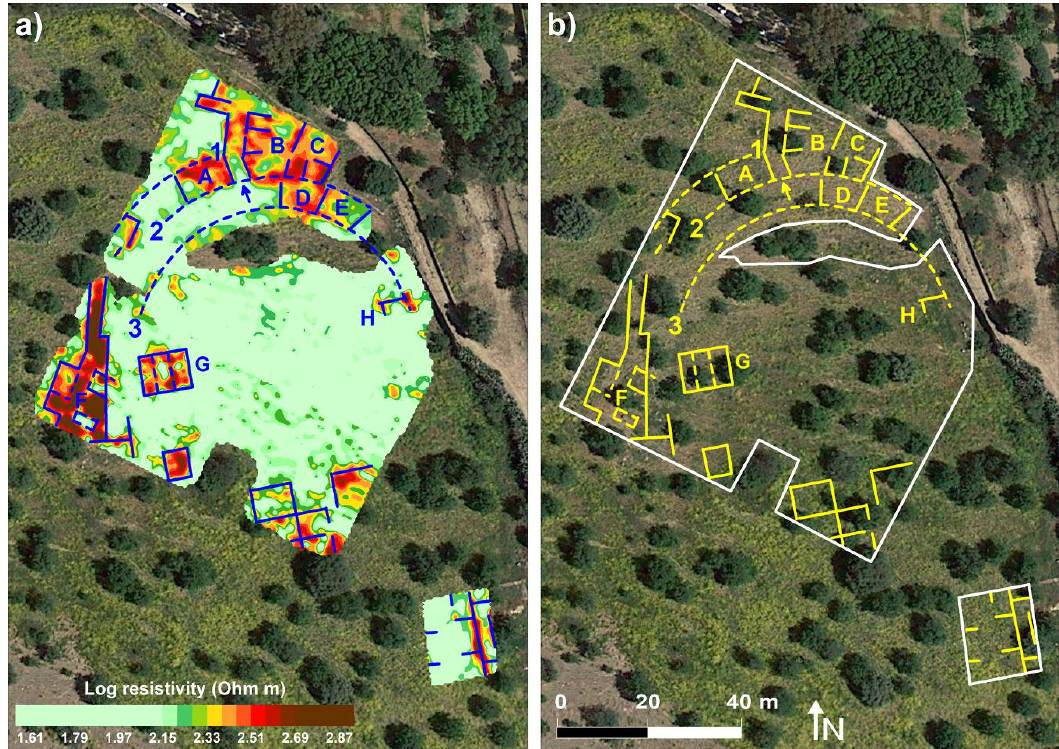
Figure 4. Modelled electrical resistivity map relative to 1 m in depth on a Google Earth TM satellite image (2016): areas 1 and 2 (modified by [16]).